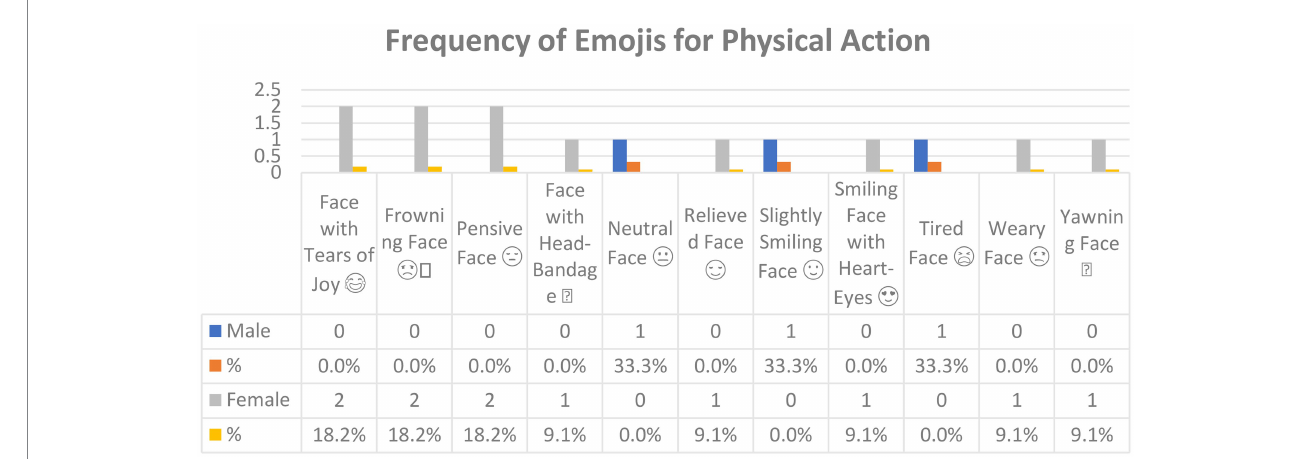
FIGURE 8 The emojis used for Physical action in Arabic tweets.